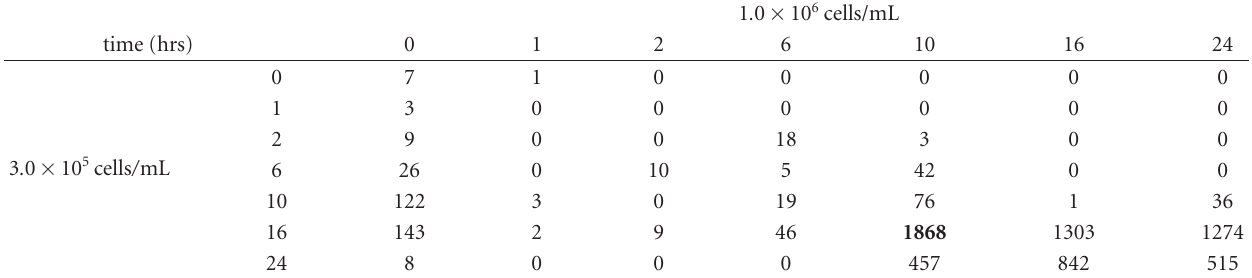
Table 7: Time evolution of